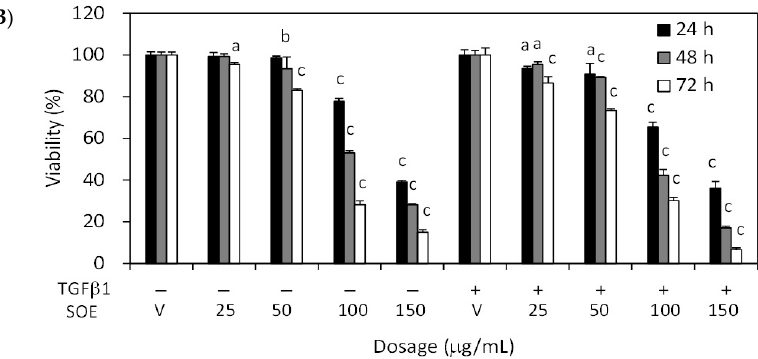
Figure 2. Effects of concentration and duration of SOE treatment on proliferation of endometrial cancer cells, with or without TGF β 1 (2.5 ng/mL) stimulation. ( A ) HEC-1A cells and ( B ) RL95-2 cells. Cancer cells were cultured in 96-well plates at a density of 1 × 10 4 cells/well. Cells were treated with 0–150 µ g/mL SOE for 24–72 h. Cell viability was measured using 3-(4,5-dimethylthiazol- 2-yl)-2,5-diphenyltetrazolium bromide (MTT) assay. Three independent experiments were conducted;